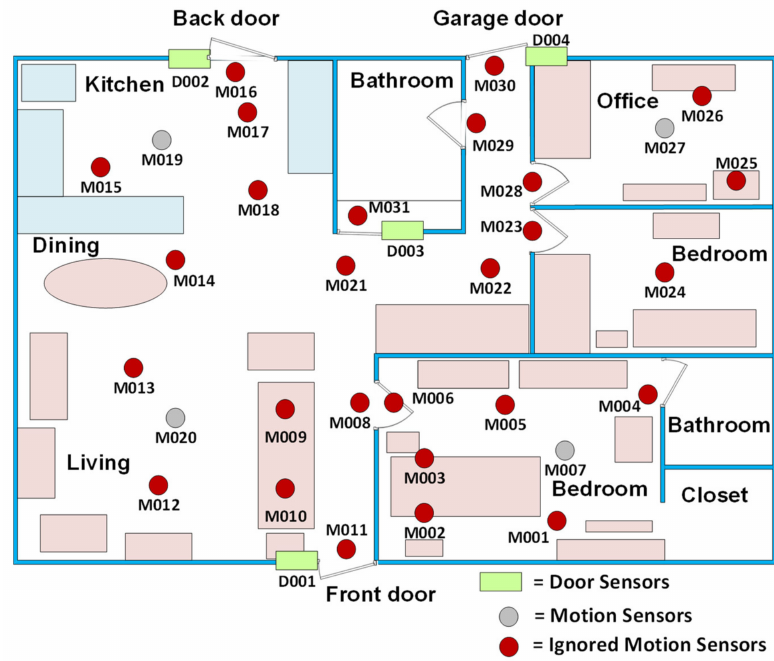
Figure 5. Aruba testbed layout where motion and door sensors are